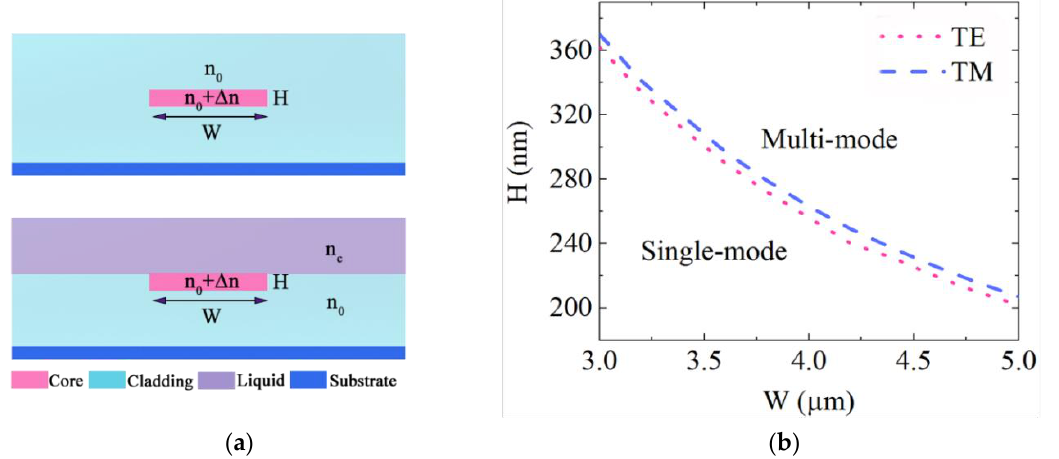
Figure 1. ( a ) Cross section of the WCSW with width W and height H with upper cladding (up) and sensing liquid (down). The refractive indices of claddings, core and liquid are n 0 , n 0 + ∆ n and n c , respectively. ( b ) Single-mode condition for TE and TM polarizations of WCSW at n 0 = 1.466 and ∆ n = 0.03.